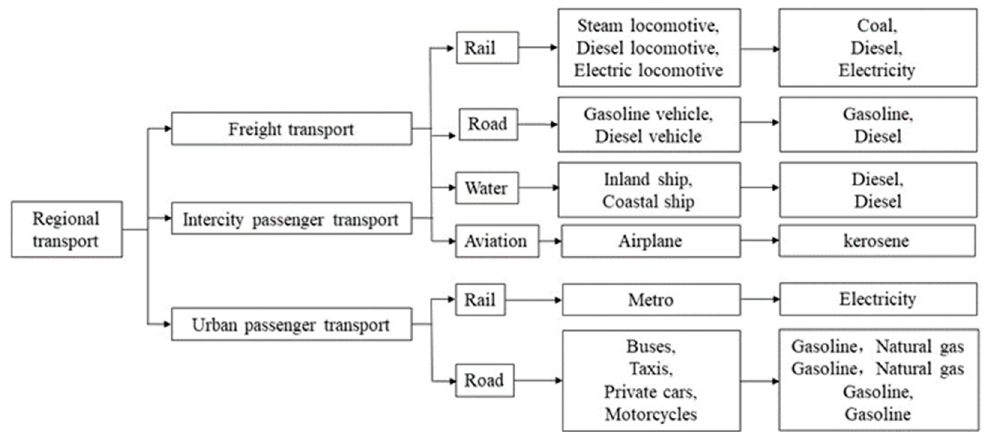
Figure 1. Architecture of calculation of CO 2 emission from transportation.